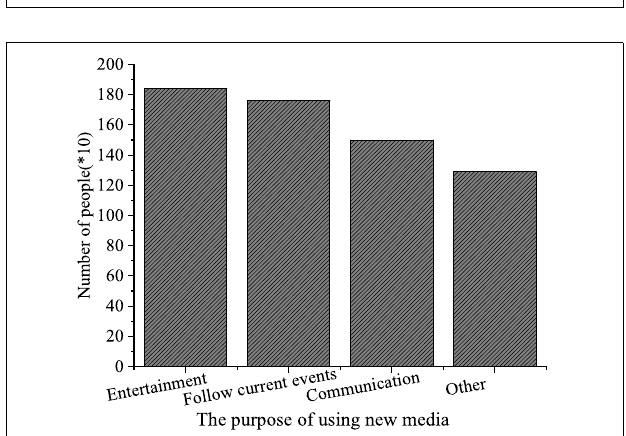
FIGURE 8 | Questionnaire Survey of purposes for using new media.